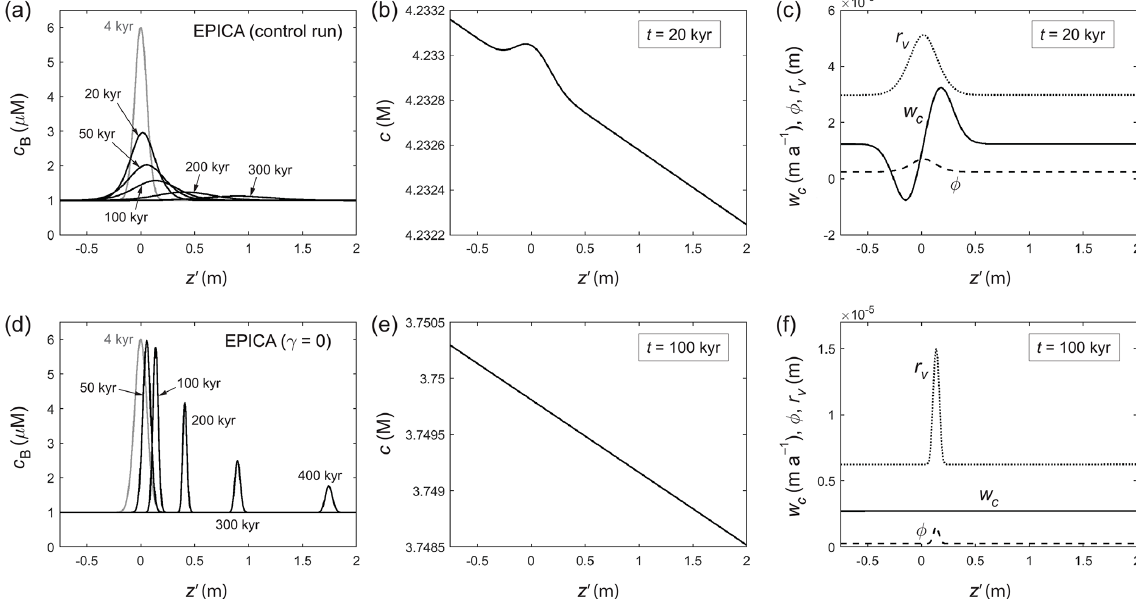
Figure 6. Modelled evolution of a signal peak in (a) – (c) the EPICA control run and (d) – (f) an otherwise identical run where the Gibbs– Thomson effect is turned off ( γ = 0). (a, d) Bulk solute concentration c B ; (b, e) vein solute concentration c at one time; (c, f) anomalous velocity w c , porosity φ , and vein curvature r v at one time. Grey curves in (a) and (d) indicate the initial doped peak. Panel (b) illustrates the Gibbs–Thomson perturbation. See Movie S2 for the full